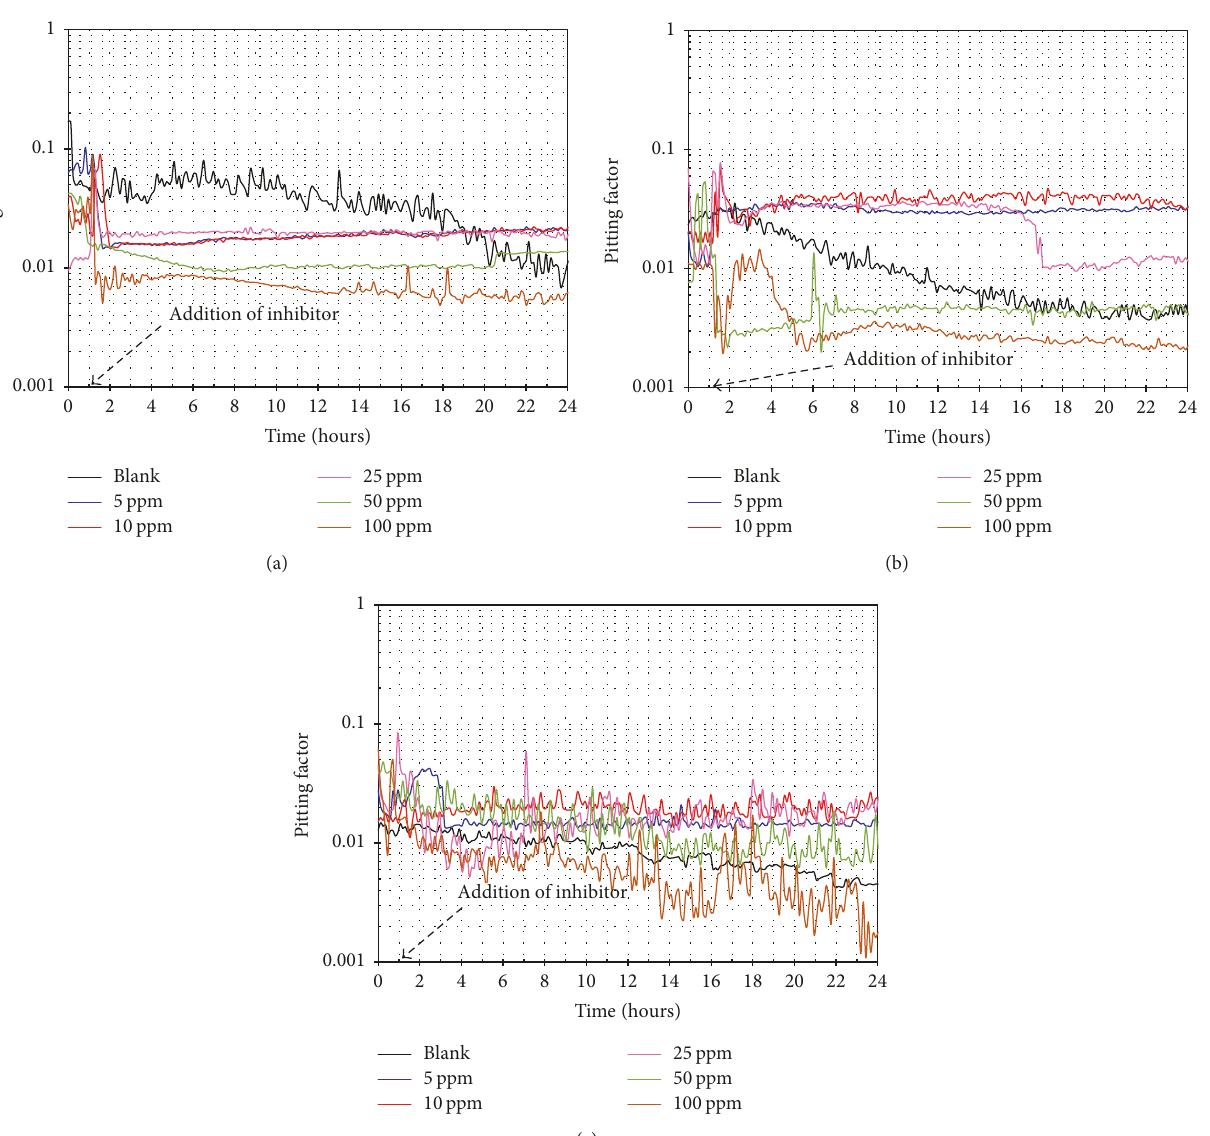
Figure 6: Variation in PF values as a function of time for API X-70 steel exposed to CO 2 -saturated saline solution at different inhibitor concentrations: (a) 30 ∘ C, (b) 50 ∘ C, and (c) 70 ∘